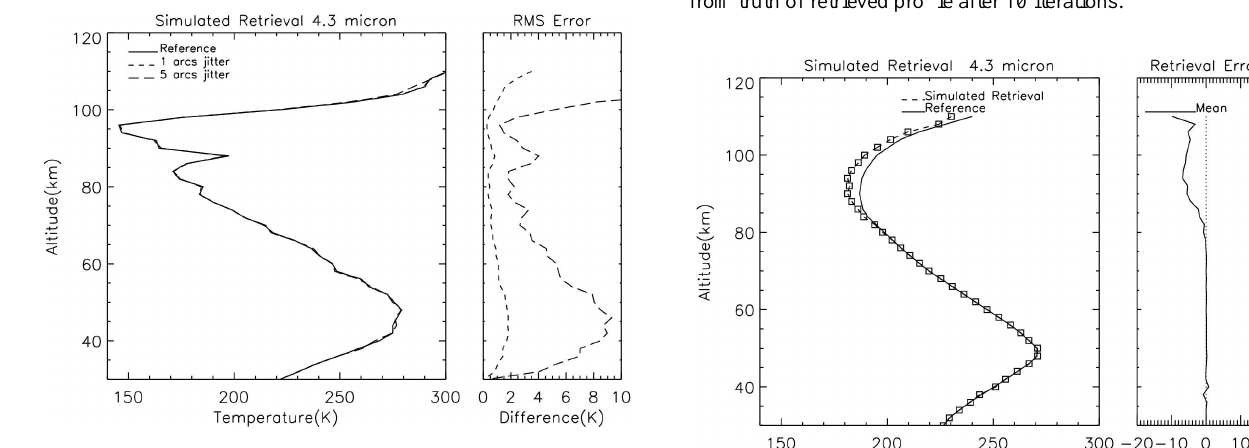
Fig. 15. Impact of random pointing error on retrieved temperature. Right-hand panel shows the RMS difference.